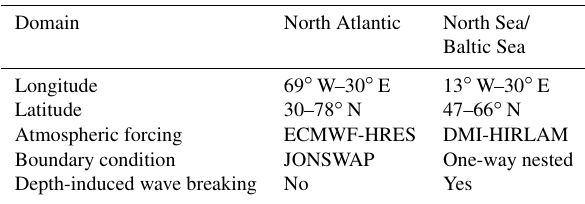
Table 1. Specifications of the DMI-WAM nested setup.